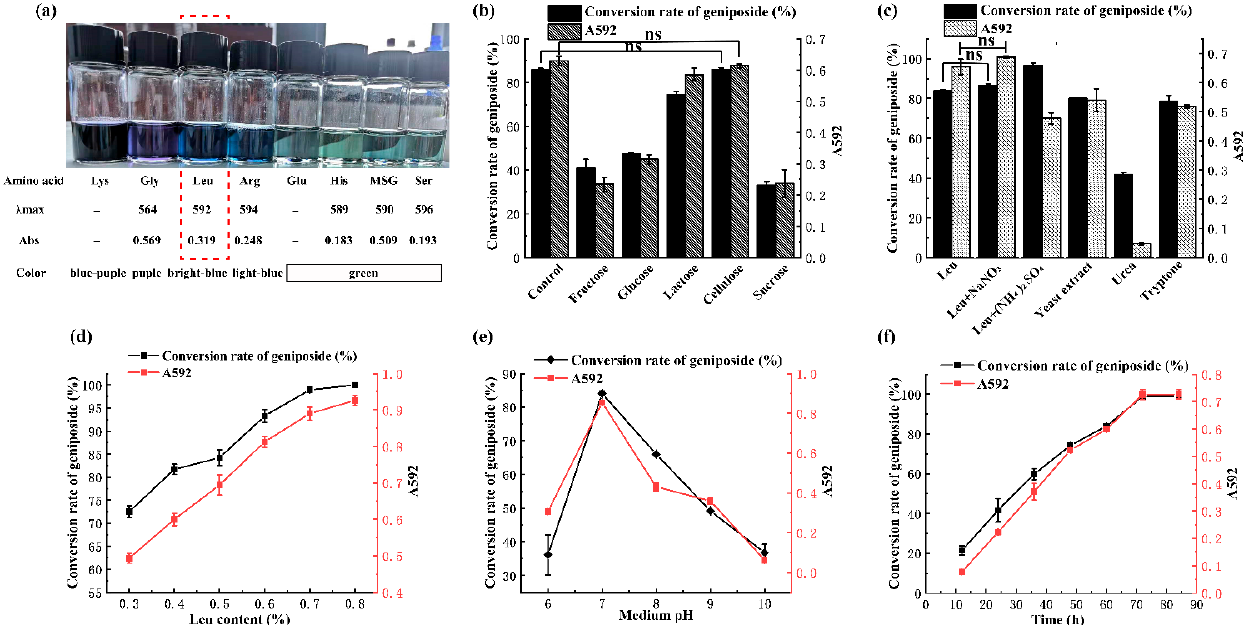
Figure 2. ( a ) Categories of amino acids affected the λ max, Abs, and color of GBP in the spectrophotometric study. λ max, maximum absorption wavelength of GBP; Abs, absorbance value of gardenia blue pigment at maximum absorption wavelength. Different C sources ( b ) and N sources ( c ), Leu content ( d ), medium pH ( e ), and reaction times ( f ) affected the geniposide conversion rate and GBP maximum absorption (yield). MSG, sodium glutamate; ns, not significant.